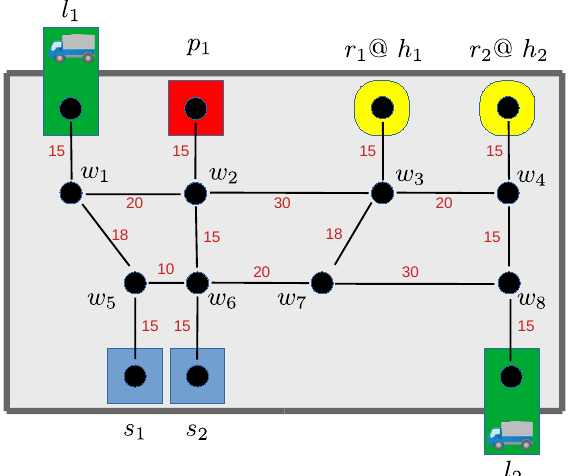
Figure 1. A graph representing a simple warehouse with loading bay vertices l 1 and l 2 , an empty pallet area p 1 , storage vertices s 1 , s 2 , waypoint vertices w 1 , . . . , w 8 , and home vertices h 1 , h 2 for robots r 1 , r 2 , respectively. Edge labels represent the minimal travel times between vertices (in